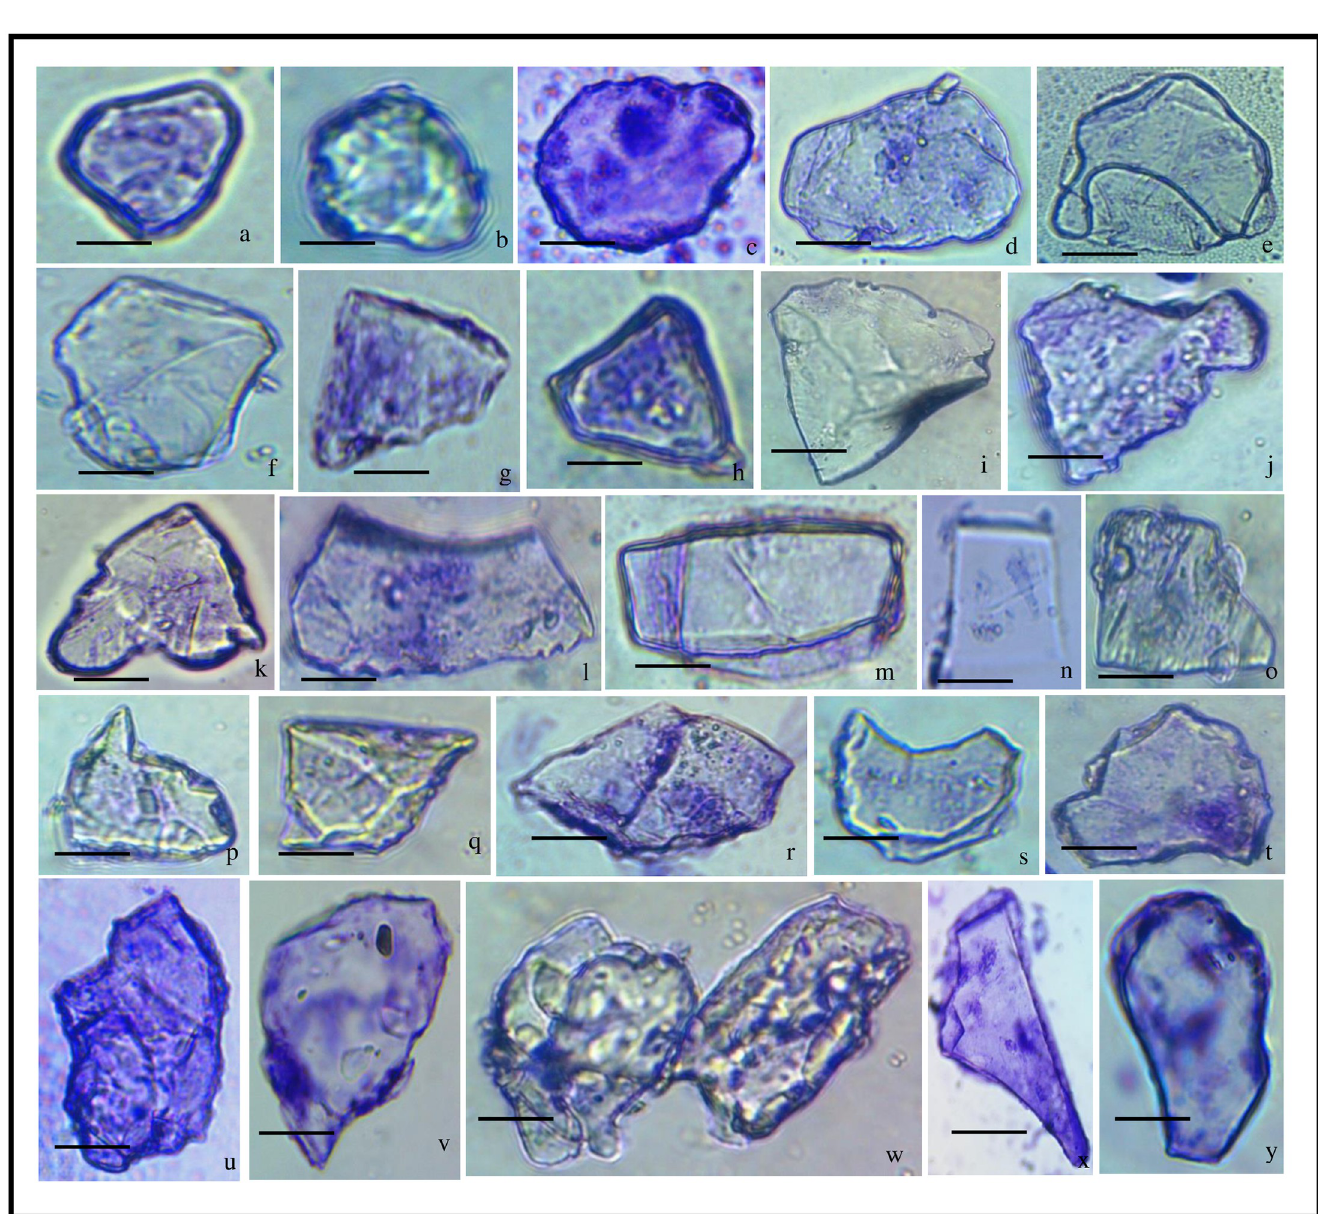
Fig 3. Phytolith morphotypes of Acrachne racemosa (Heyne ex Roem. & Schult.) Ohwi (Root). Globular psilate (a); Globular granulate (b, c); Blocky polyhedral (d); Globular polyhedral (e, f); Triangular (g-k); Trapezoid (l); Tabular simple (m); Trapezoid (n, o); Acute bulbous (p); Prism (q, r); Blocky polyhedral (s); Tabular polyhedral (t); Blocky irregular (u); Tabular irregular (v); Nodular (w); Cuneiform bulliform (x, y) bar = 20 μ m.